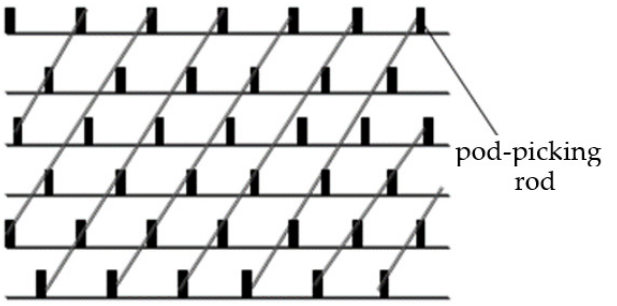
Figure 2. Distribution of the pod-picking rods.